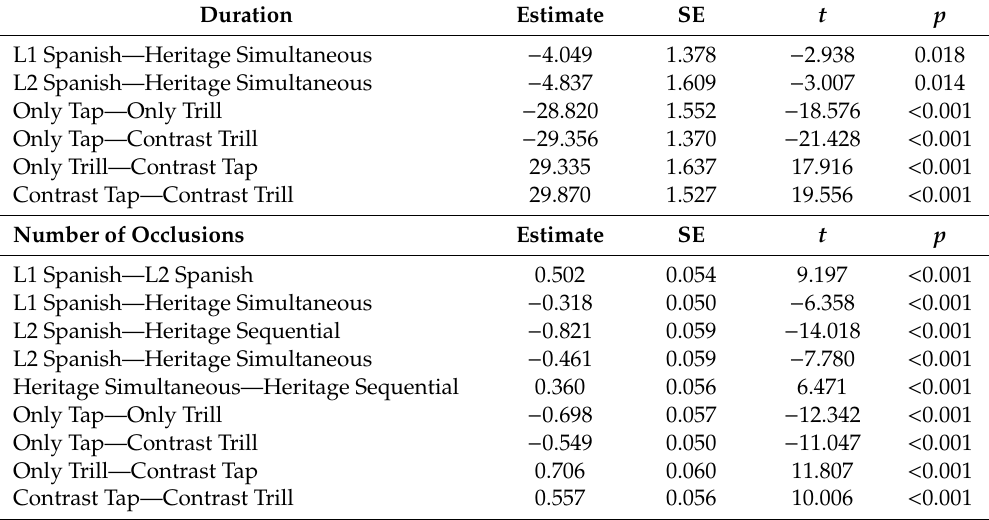
Table 3. Statistically significant estimated marginal means (EMMs) for all participant groups and rhotic